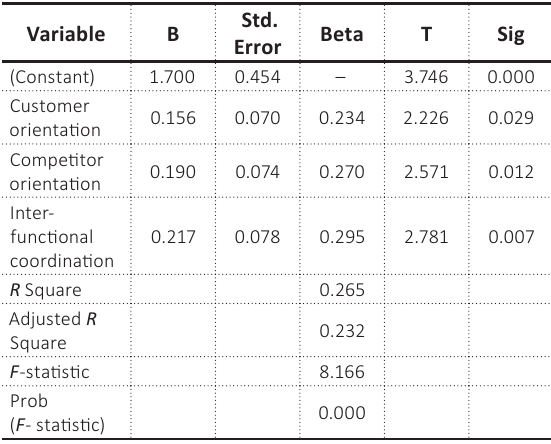
Table 11. Multiple regression analysis